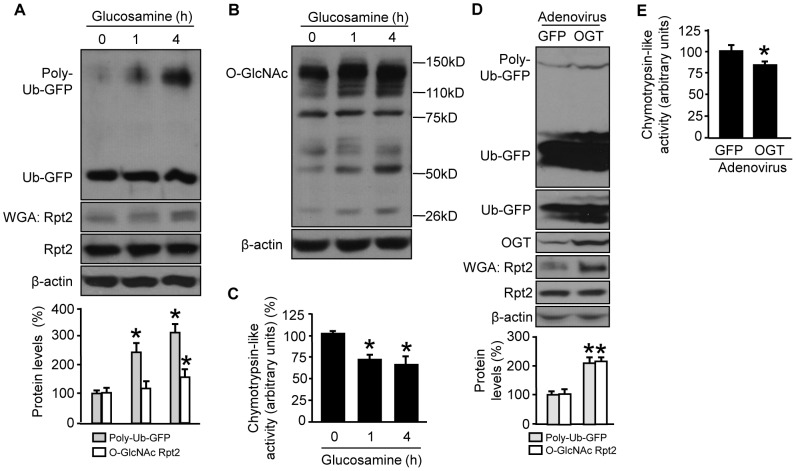
Upregulation of either O-GlcNAcylation or OGT suppresses 26S proteasome functionality.The UbG76V-GFP-transfected HUVEC were treated with vehicle (medium) and glucosamine (5 mM) for indicated time up to 4h and followed by (A) quantifications of poly-Ub-GFP protein levels with an anti-GFP antibody and O-GlcNAc modification of Rpt2 with an anti-Rpt2 antibody (on WGA pull-down) in Western blot; (B) Western blotting of global O-GlcNAc modified proteins with an anti-O-GlcNAc antibody; (C) proteasomal chymotrypsin-like activity assay. (D) Overexpression of OGT not GFP increased both Rpt2 O-GlcNAcylation and the levels of reporter protein. (E) Chymotrypsin-like activity in GFP- and OGT-overexpressing cells. The blots shown were representative of 3 independent experiments with similar results. * represents p<0.05 vs the control (n = 3). An overlaid portion (less exposure) of each whole blot indicating Ub-GFP is presented. Ub-GFP, ubiquitin-green fluorescent protein; OGT, O-GlcNAc transferase; UDP-GlcNAc, Uridine diphosphate-GlcNAc; WGA, wheat germ agglutinin.